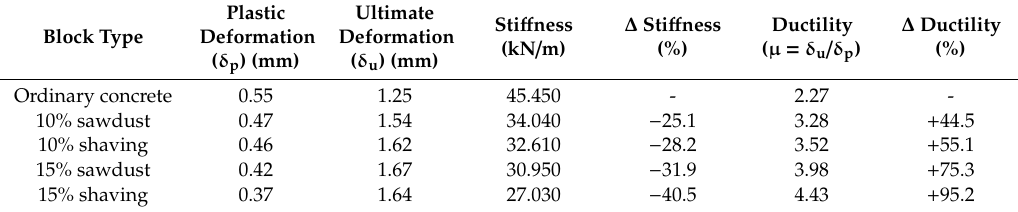
Table 4. Deformations and ductility of all tested concrete blocks suitable for structural